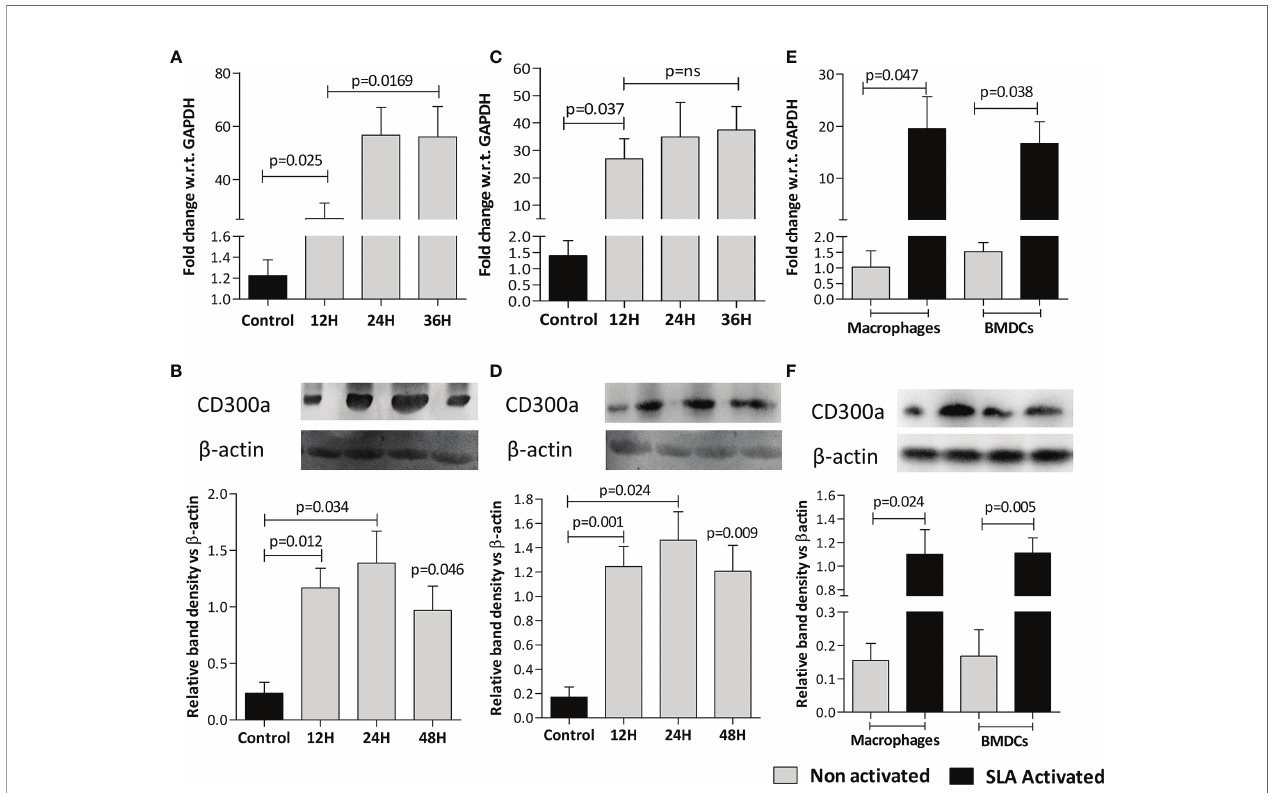
FIGURE 1 | L. donovani infection and leishmanial antigen exposure induce CD300a expression in macrophages (M j ) and BMDCs. The CD300a expression both, at mRNA and protein levels invariably increased in M j -like cell line RAW 264.7 (A, B) and BMDCs (C, D) on infection with parasites (at 1:10 ratio for 6h) at all time points tested post infection as compared to uninfected control. The soluble leishmanial antigens (SLA) also signi fi cantly induced CD300a expression in uninfected macrophages and dendritic cells at both mRNA (M j p=0.047; BMDCs p=0.038; E ), and protein (M j p=0.024; BMDCs p=0.005; F ) levels as compared to nonactivated